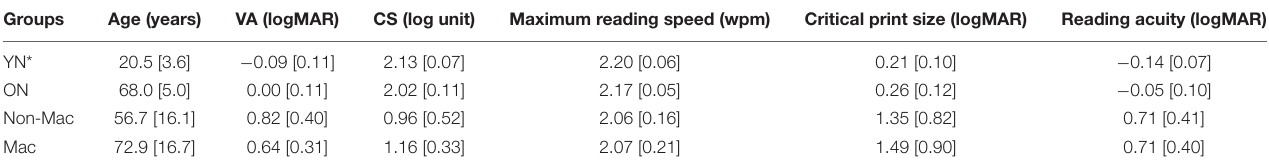
FIGURE 2 | Simulated low vision conditions. (A) The horizontal and vertical scaling factors of the forty simulated low vision conditions. Twenty-five conditions (solid dot) were determined so that the reductions in CS and VA would closely resemble the empirical distribution (see B for details). Fifteen conditions (empty dot) were boundary conditions. (B) The empirical distribution of CS reduction as a function of VA reduction, both compared to Age-adjusted normal baselines, in a large sample of subjects ( N = 1,040) with various vision conditions (adapted from Xiong et al., 2020). The gray line represents the regression line, and the gray ribbon represents the 95% confidence interval around the regression line. The black solid dots represent the CS and VA reductions in the 25 simulations. Note that in B the VA axis was reversed, i.e., from large to small, to visualize the correspondence between A and B . In both figures, the cross represents the baseline condition without filtering. TABLE 2 | Age, vision status, and reading performance of the young normal (YN), older normal (ON), non-macular (Non-Mac) and macular (Mac) groups (mean [standard deviation]).